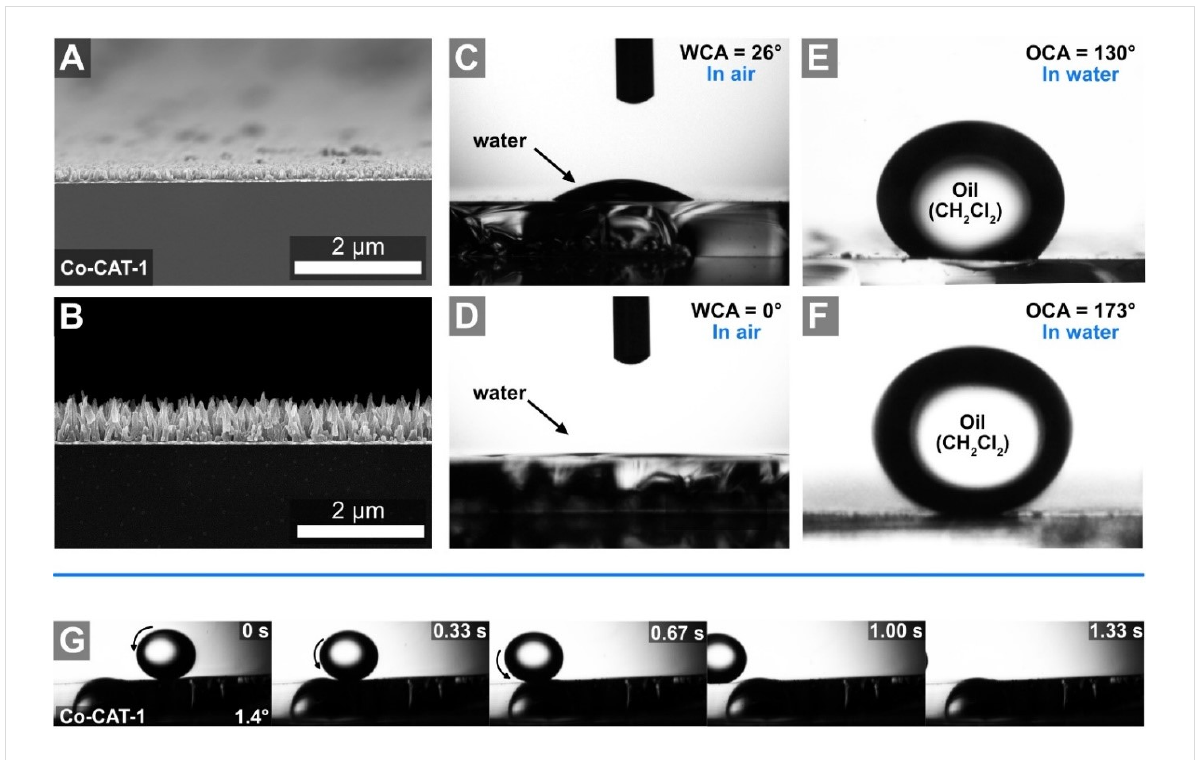
Figure 3: Cross-section SEM micrographs of A) an oriented and compact Co-CAT-1 film and B) an oriented (pillar-like) nanostructured Co-CAT-1 film. WCA of the C) compact (WCA = 26°) and the D) nanostructured (WCA = 0°) films. Underwater OCA (dichloromethane (DCM)) of the E) compact (CA = 130°) and the F) nanostructured films (CA = 173°). G) An image series of a self-cleaning surface experiment (3 frames per second) with DCM as an oil droplet placed on the nanostructured Co-CAT-1 film performed at a substrate tilt angle of 1.4°.